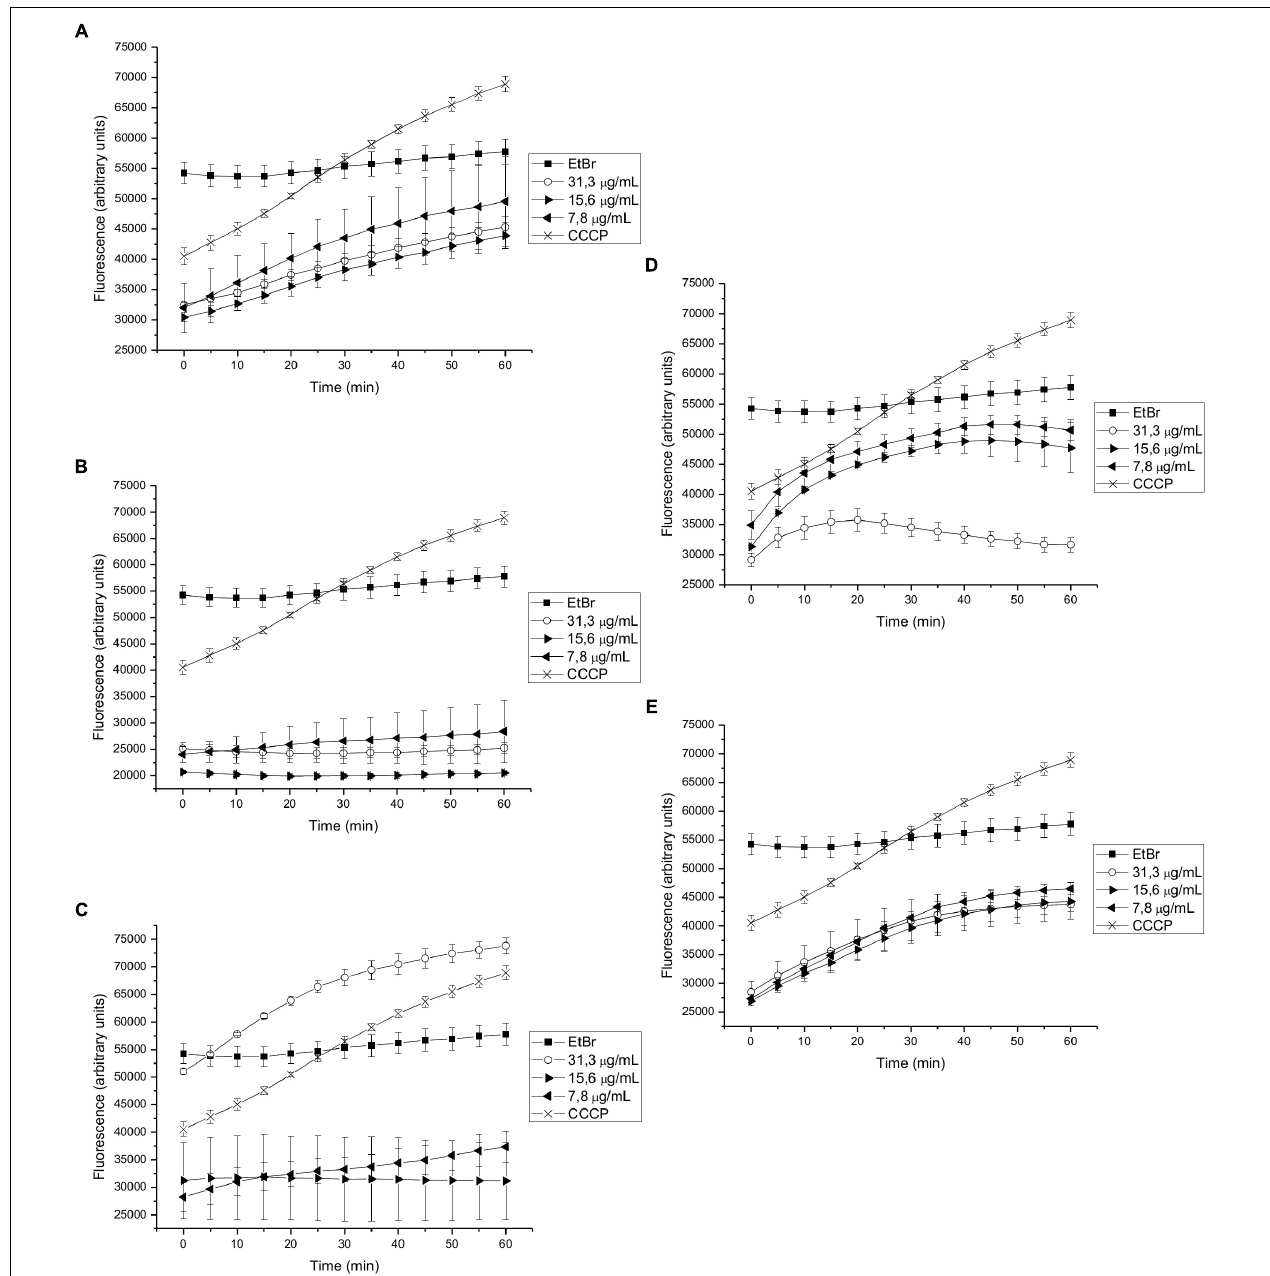
FIGURE 4 | Effect on the intracellular accumulation of ethidium bromide of (A) DCME extract, (B) epi -cubenol (4), (C) 15-copaenol (6), (D) 15-copaenal (6OX), and (E) 15-copaenyl acetate (6AC) in K1902 ( (cid:77) norA ) strain. The bacteria were exposed to 2.0 µ g/mL of EtBr at 37 ◦ C for a period of 1h in the presence of glucose. CCCP (1.25 µ g/mL) was used as inhibitor